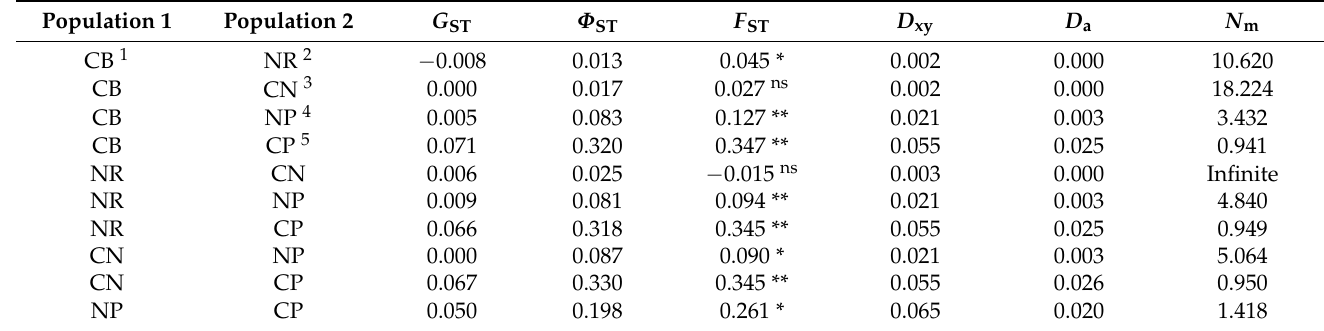
Table 6. Genetic differentiation between the three populations of Siamese ( Crocodylus siamensis , Schneider, 1801) [1] and saltwater crocodiles ( Crocodylus porosus , Schneider, 1801) [13] for the mito- chondrial DNA D-loop sequence. Genetic differentiation coefficient ( G ST ), Wright’s F -statistic for the subpopulations within the total population ( F ST ), Φ ST , gene flow ( N m ) from the sequence data and the haplotype data, the average number of nucleotide substitutions per site between populations ( D xy ), and the net nucleotide substitutions per site between populations ( D a ).